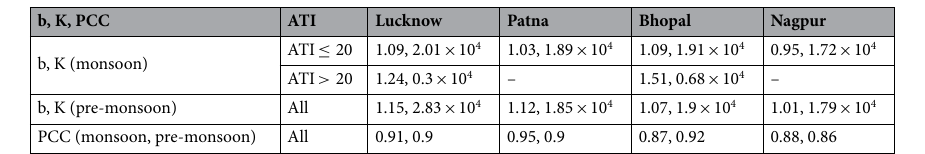
Table 2. Properties of RERV-ATI relationships and Pearson correlation coefficient (PCC) at 99% significant interval. Here, K and b are the coefficient and exponent respectively in RERV-ATI relationships.